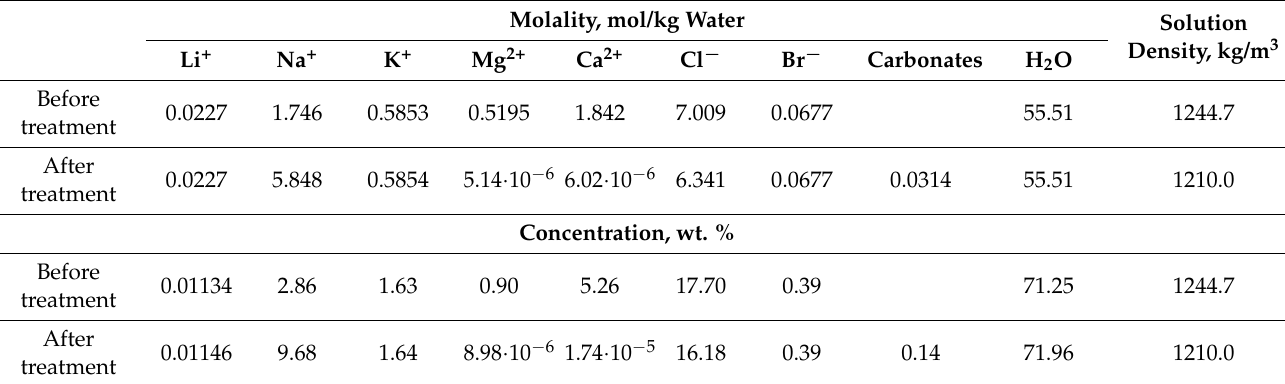
Table 4. Change in the composition of the geothermal brine during soda ash treatment (calculation with PHREEQC).